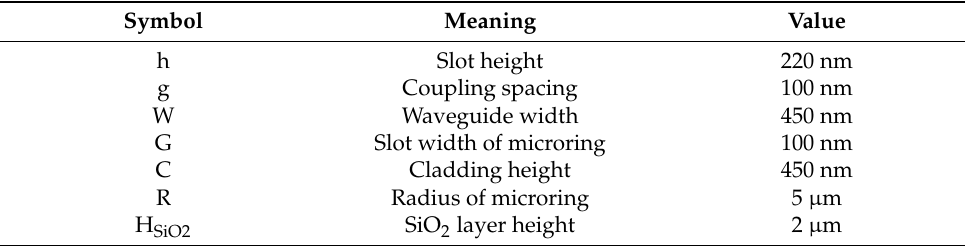
Table 1. Size parameters of microring resonator.